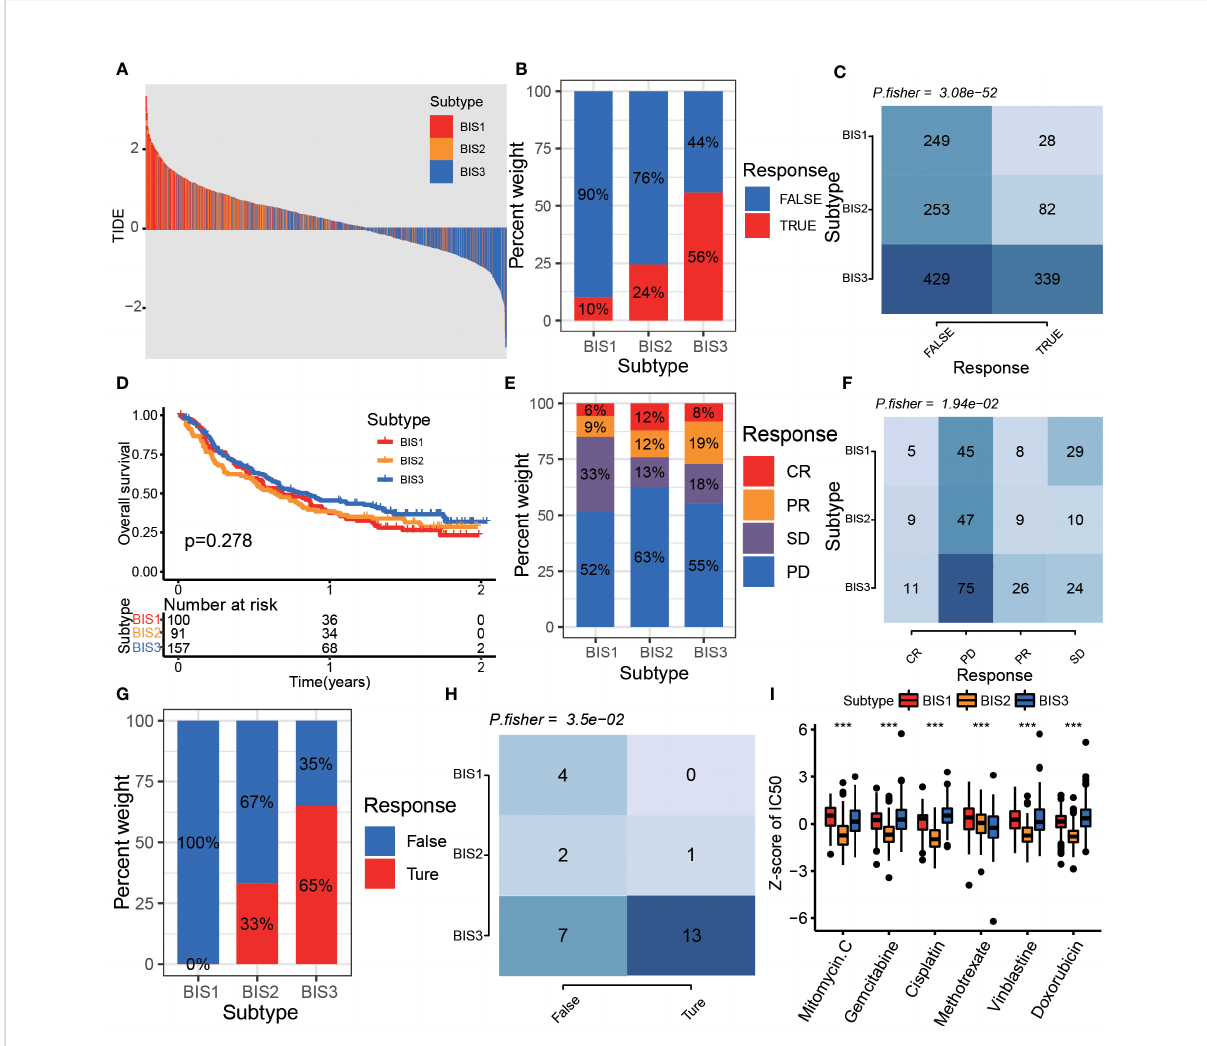
FIGURE 8 The drug sensitivity of different subtypes. (A) The distribution of TIDE score among the three subtypes in Meta cohort. The proportion (B) and Fisher ’ s test (C) of immunotherapy response samples in different subtypes in Meta cohort. (D) Survival analysis for three subtypes in the IMvigor210 cohort. The proportion (E) and Fisher ’ s test (F) of immunotherapy response samples in different subtypes in the IMvigor 210 cohort. The proportion (G) and Fisher ’ s test (H) of immunotherapy response samples in different subtypes in GSE78220 cohort. (I) The boxplot of z- score of chemotherapy drug IC50 between three subtypes in the TCGA BLCA cohort. ***P <